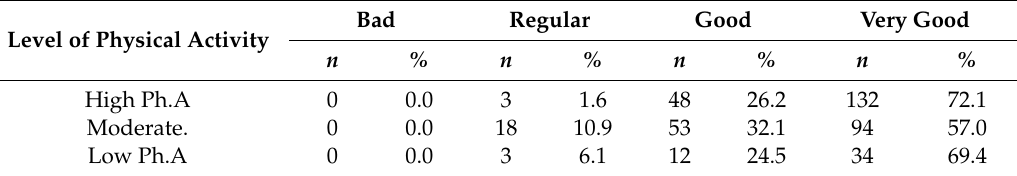
Table 3. Frequencies of the functional autonomy subscale (CUBRECAVI) according to level of physical activity. Bad Regular Good Level of Physical Activity